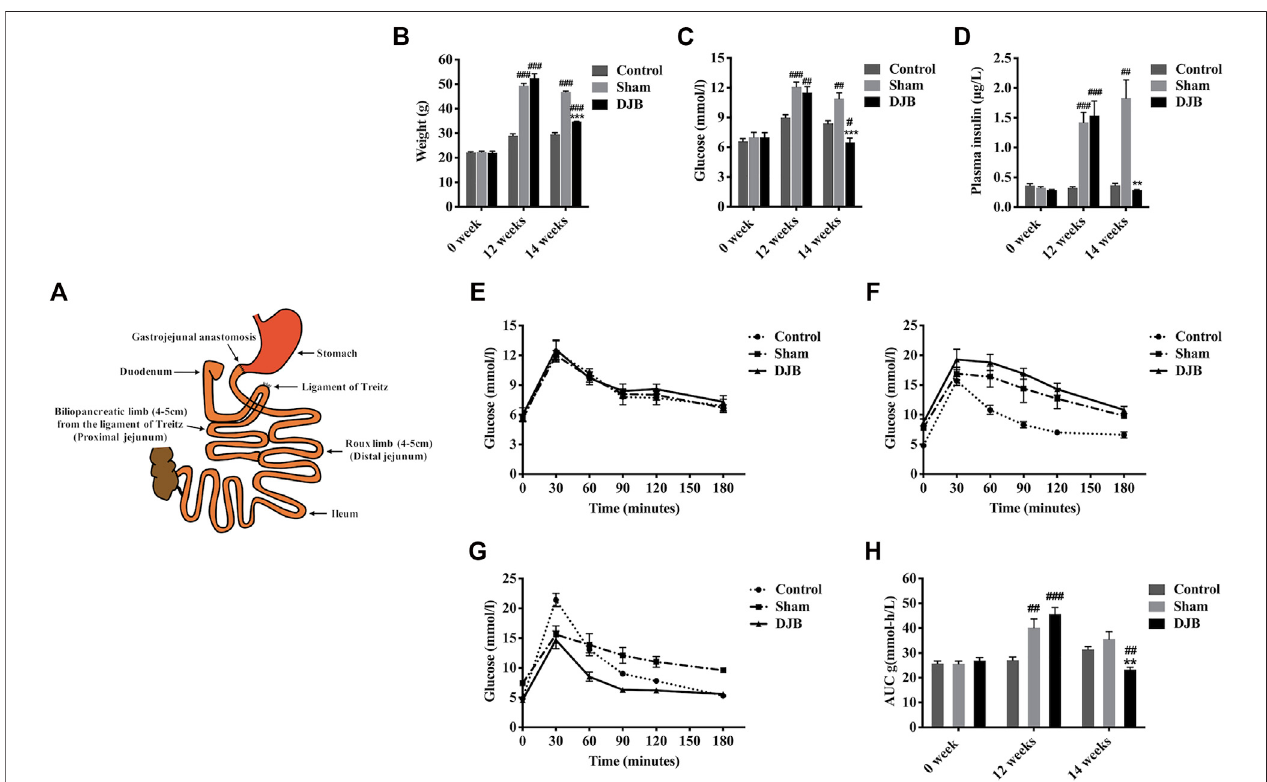
FIGURE1| CharacterizationoftheHFD-inducedT2DMmousemodelandsurgicaloutcomes.SchematicdiagramofDJBsurgery (A) .Weight (B) ,FBG (C) ,plasma insulin (D) , OGTTbefore HFD induction (E) , OGTT at 12 weeks after HFD induction and before DJB (F) , 14 weeks on HFD and 2 weeks after DJB surgery (G) , and area under the curve (AUC) of OGTT glucose excursion (H) . All values are shown as mean ± SEM. Statistical differences were analyzed by the Student ’ s t -test. * For DJB group versus sham group, # for DJB or sham group versus control group (* p < 0 .05, ** p < 0 .01, *** p < 0 .001, # p < 0 .05, ## p < 0 .01, ### p < 0 .001).